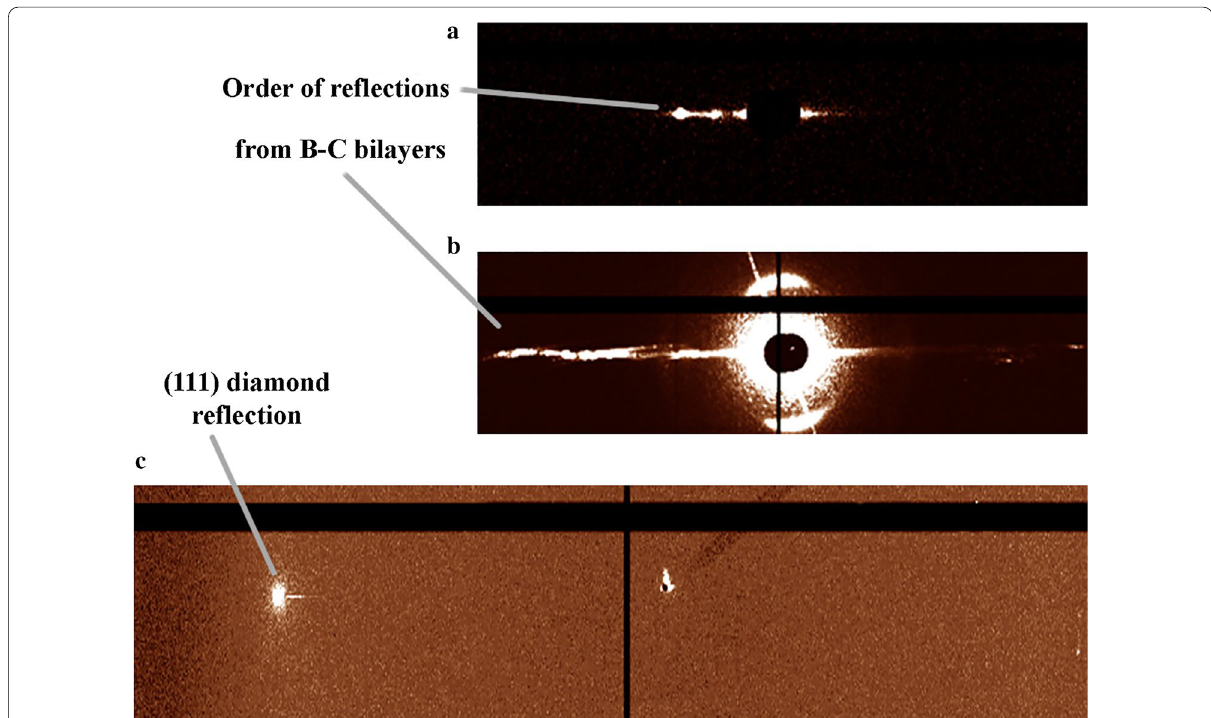
Fig. 2 X-ray nanobeam diffraction patterns obtained from a local area of BDD plate: a 2D image of the diffraction pattern, b the same diffraction pattern in another intensity scale and c X-ray diffraction pattern, recorded with a lower intensity of the primary X-ray beam, allowing the observation of the high-intensity (111) diamond